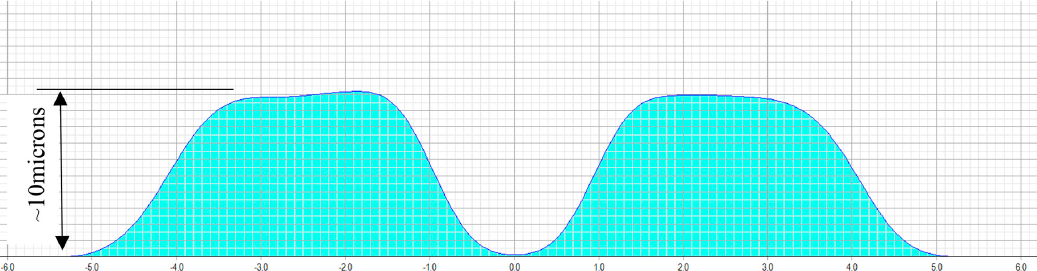
Figure 2. Typical multifocal ablation profile of a presbyopia-only treatment. The schematic indicates the amount of ablated tissue (blue area), with respect to the distance from the center of the cornea. Such a profile creates a steep central zone of 3 mm, providing extra refractive power for near-vision.